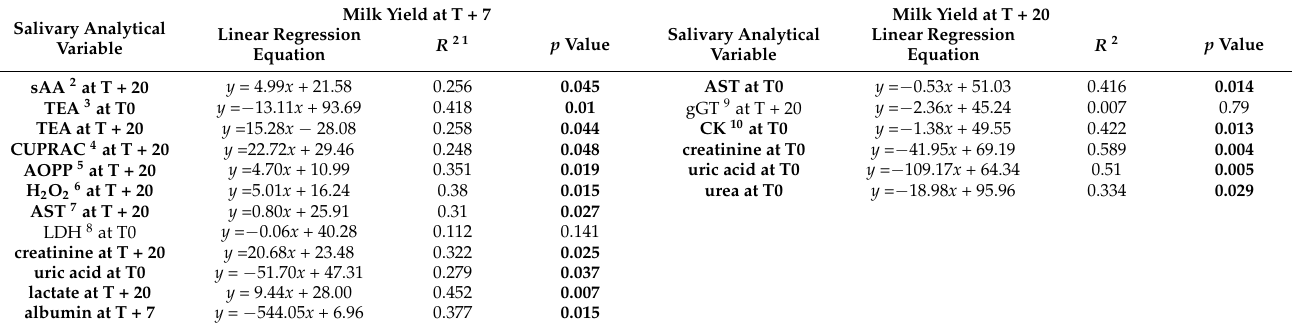
Table 3. Multiple linear regression analyses in 13 dairy cows during their peripartum period between the dependent variable milk yield at T + 7 and T + 20, and some salivary analytes at different time of samplings as independent variables. The times were T − 13: at − 13 ± 6.91 days relative to calving; T0: within the 12 first hours after calving; T + 7: seven days after calving; T + 20: 20 days after calving. The analytical variable in bold showed significance. Salivary Analytical